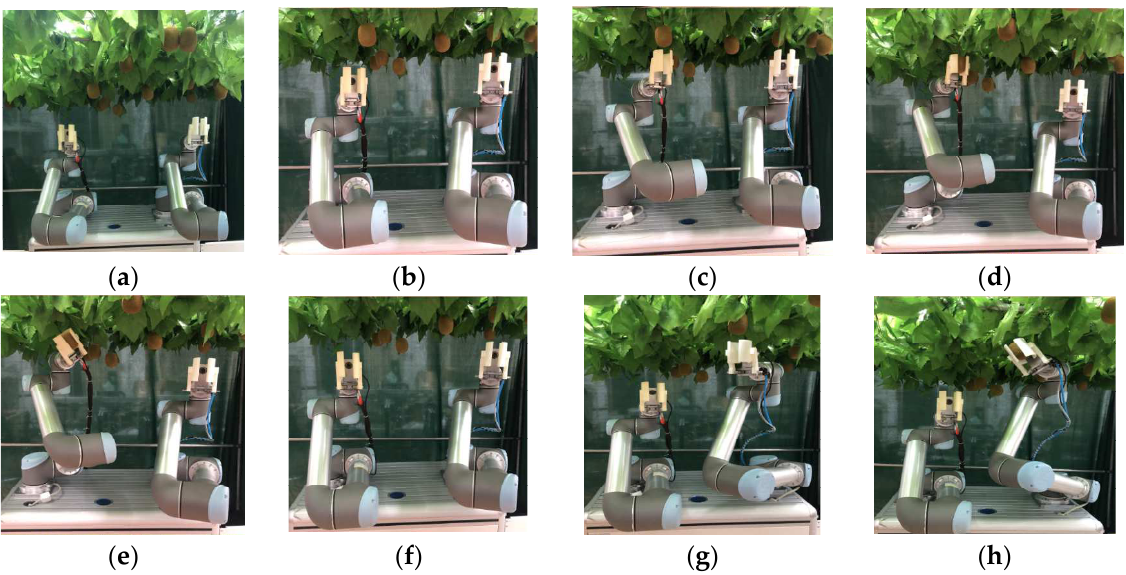
Figure 22. The process of double-arm motion in the collision-prone region. ( a ) Initial location. ( b ) Collision detection. ( c ) Left robotic arm positioning fruit. ( d ) Left robotic arm picking fruit. ( e ) The left robot arm separates the fruit. ( f ) The left robot arm reaches the initial position. ( g ) The right robot arm grabs the fruit. ( h ) The right robot arm separates the fruit.